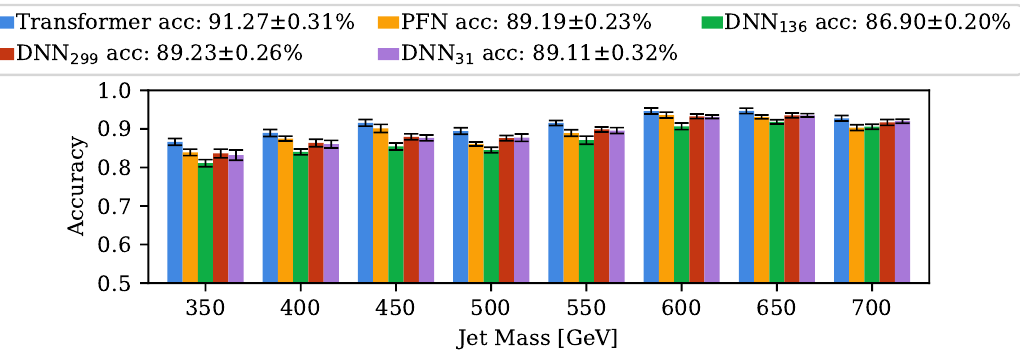
Figure 10 . Mean 10-fold accuracy and statistical uncertainty of the various networks predictions for jets within ranges of jet mass. The jets are binned according to their mass in intervals of 50 GeV. The x-axis labels correspond to the upper bound of the